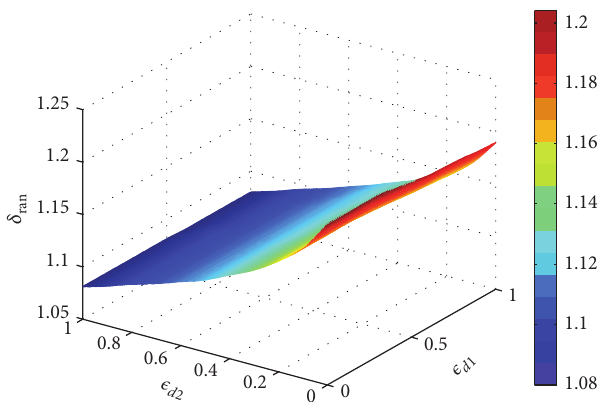
Figure 7: The simulation of correlation between pair ( 𝜖 𝑑1 ,𝜖 𝑑2 ) and 𝛿 ran